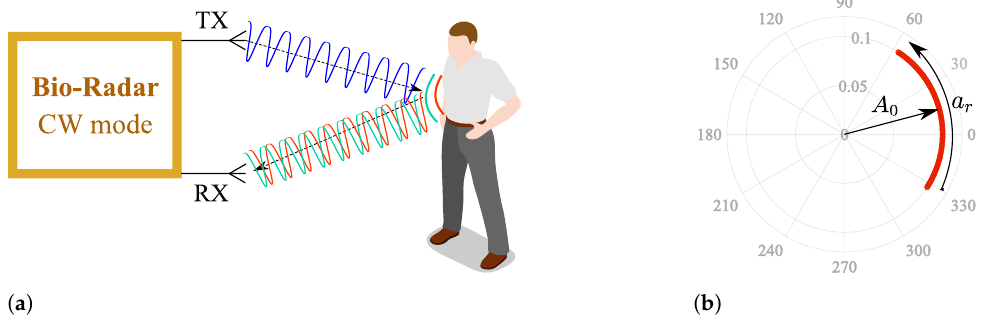
Figure 1. CW bio-radar operating principle, where TX is the transmitting antenna and RX is the receiving antenna: ( a ) Illustration of an ideal scenario, ( b ) Resulting baseband signal in the complex plane for an ideal